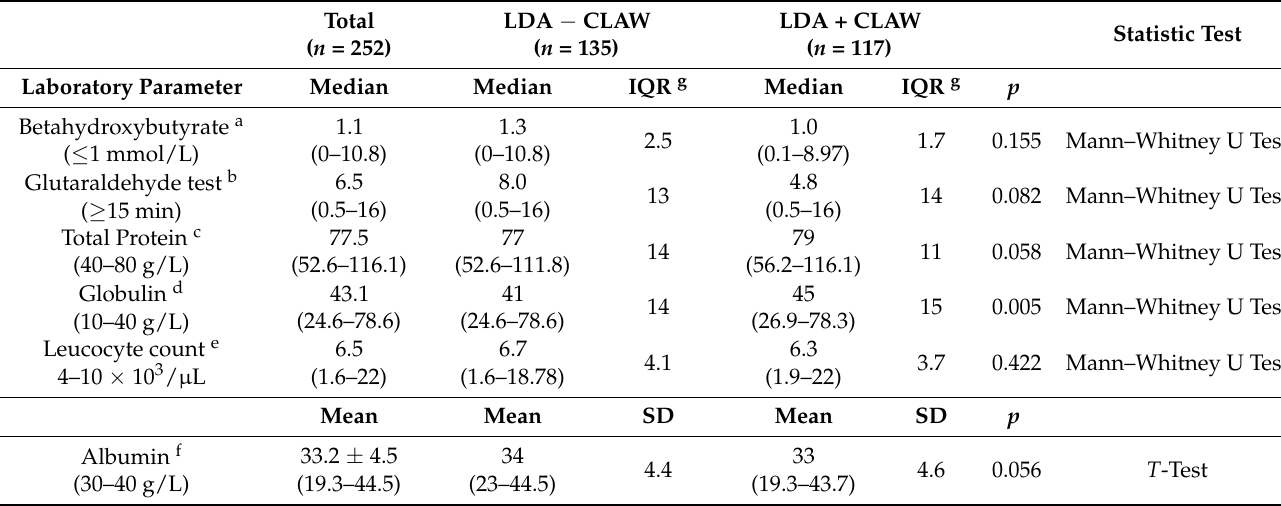
Table 2. Laboratory findings of animals diagnosed with left displacement of the abomasum (LDA) and either no claw lesion (LDA − CLAW) or at least one claw lesion (LDA + CLAW). Ranges and physiologic values are given in brackets. Results with a p -value < 0.05 were considered statistically significant and are printed in bold letters. Median and Inter-Quartile- Range (IRQ) are given for data which were not normally distributed mean and standard deviation (SD) for data, which were normally distributed. Statistical methods for differently distributed data are indicated.